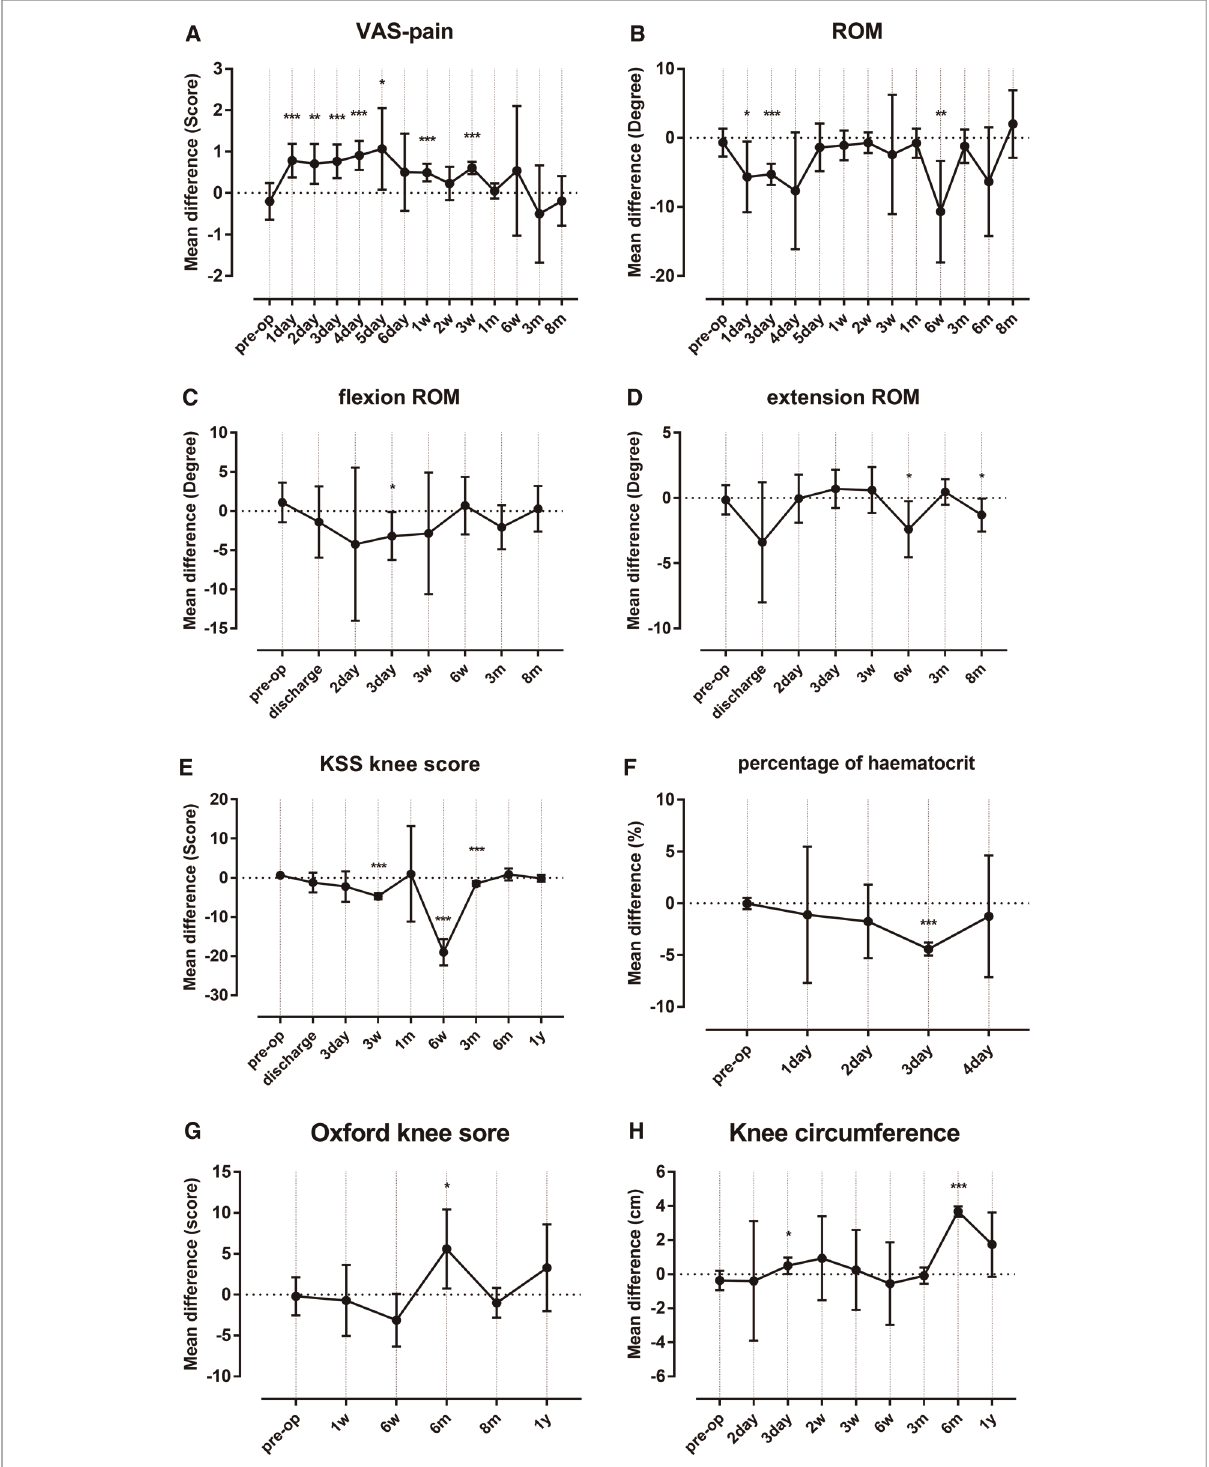
FIGURE 3 Results for subgroup meta-analyses for outcomes including VAS-pain score ( A ), ROM ( B ), fl exion ROM ( C ), extension ROM ( D ), KSS ( E ), percentage of HCT ( F ), Oxford knee score ( G ), and knee circumference ( H ). The error bars in the plot represent mean±95%CI. * P <0.050, ** P <0.010, *** P <0.001. VAS, visual analog scale; ROM, range of motion; KSS, Knee Society Score; HCT,